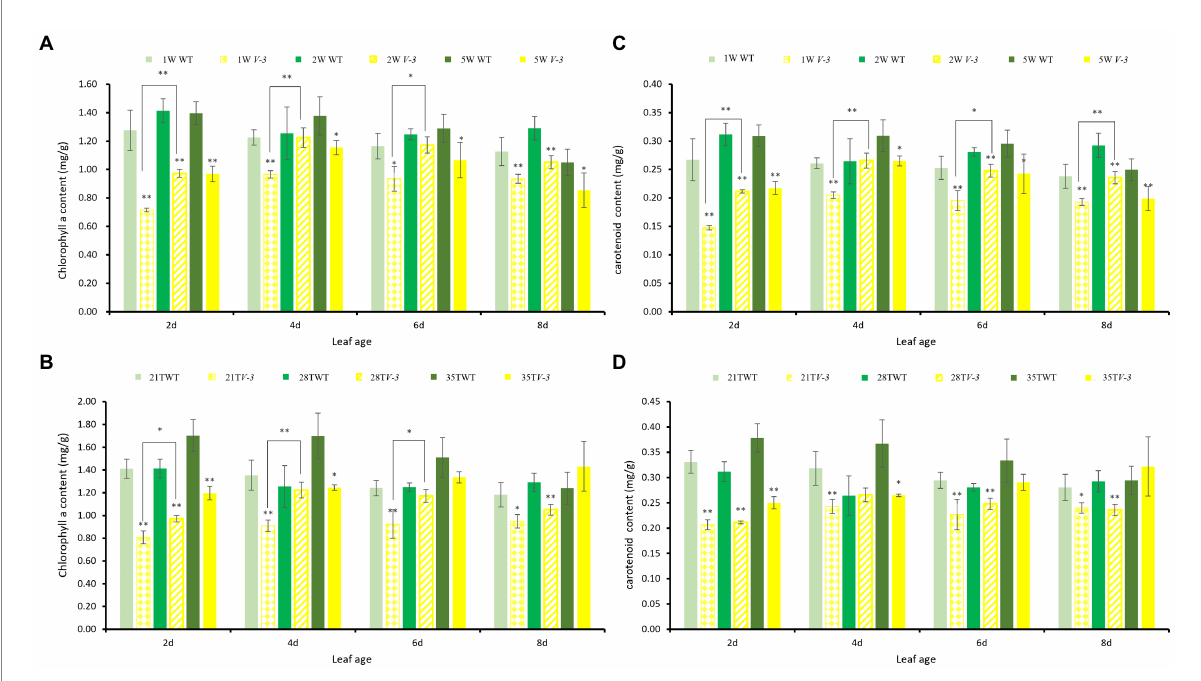
FIGURE 3 The leaf pigment contents of v-3 and the WT under different light intensity and temperature treatments. (A) Chlorophyll a content of v-3 and the WT under different light intensity treatments. (B) Chlorophyll a content of v-3 and the WT under different temperature treatments. (C) Carotenoid content of v-3 and the WT under different light intensity treatments. (D) Carotenoid content of v-3 and WT under different temperature treatments. Values are the mean ± SD. SD, standard deviation; WT, wild type. * p < 0.05. ** p <